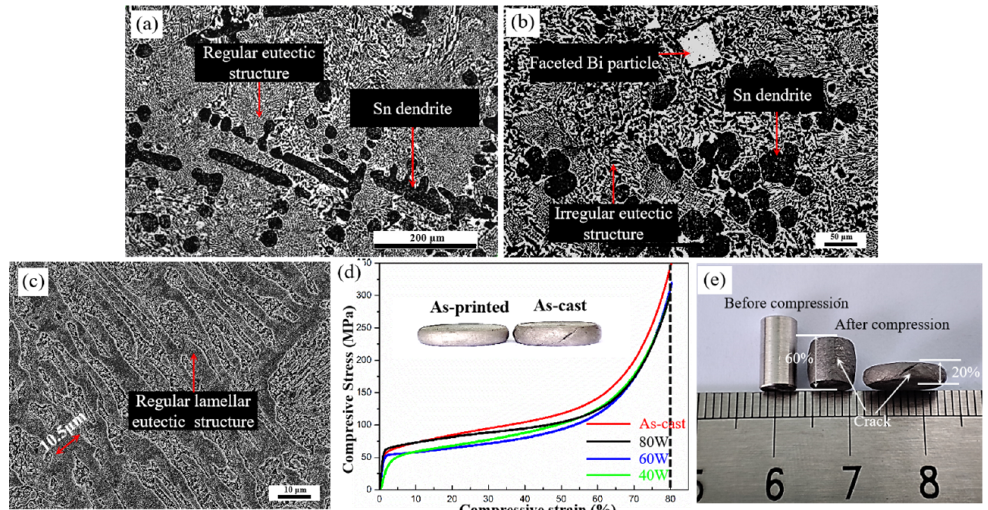
Figure 6. The microstructure and compression test result of as-cast Sn58Bi alloy: ( a – c ) SEM pictures of as-cast Sn58Bi alloy, ( d , e ) compression test result of as-cast and as-printed specimen.